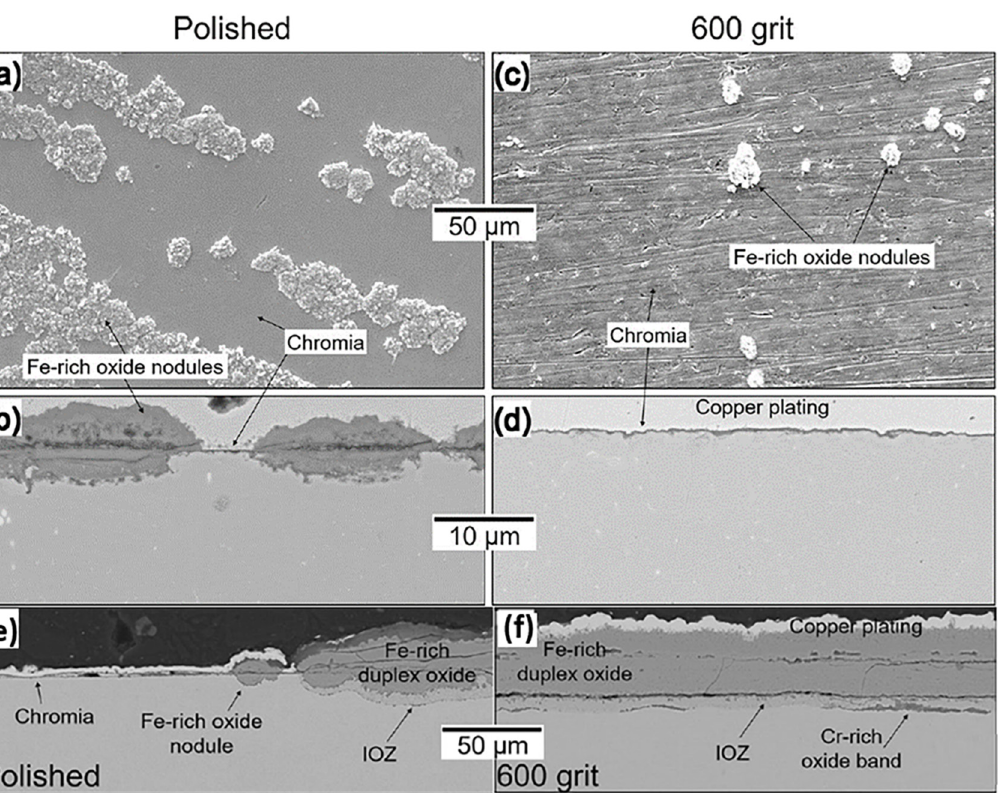
Figure 11. Surface and cross-sectional SEM images of austenitic steel 347H with two different surface treatments after exposure to 20 MPa/550 ◦ C S-CO 2 for 1500 h. ( a , b ) Polished; ( c , d ) 600-grit. Cross-sectional SEM images of FMs Grade 91 with two different surface finishes after exposure to 550 ◦ C/1 bar CO 2 for 1500 h. ( e ) Polished; ( f ) 600 grit [75]. Reproduced with permission from Springer